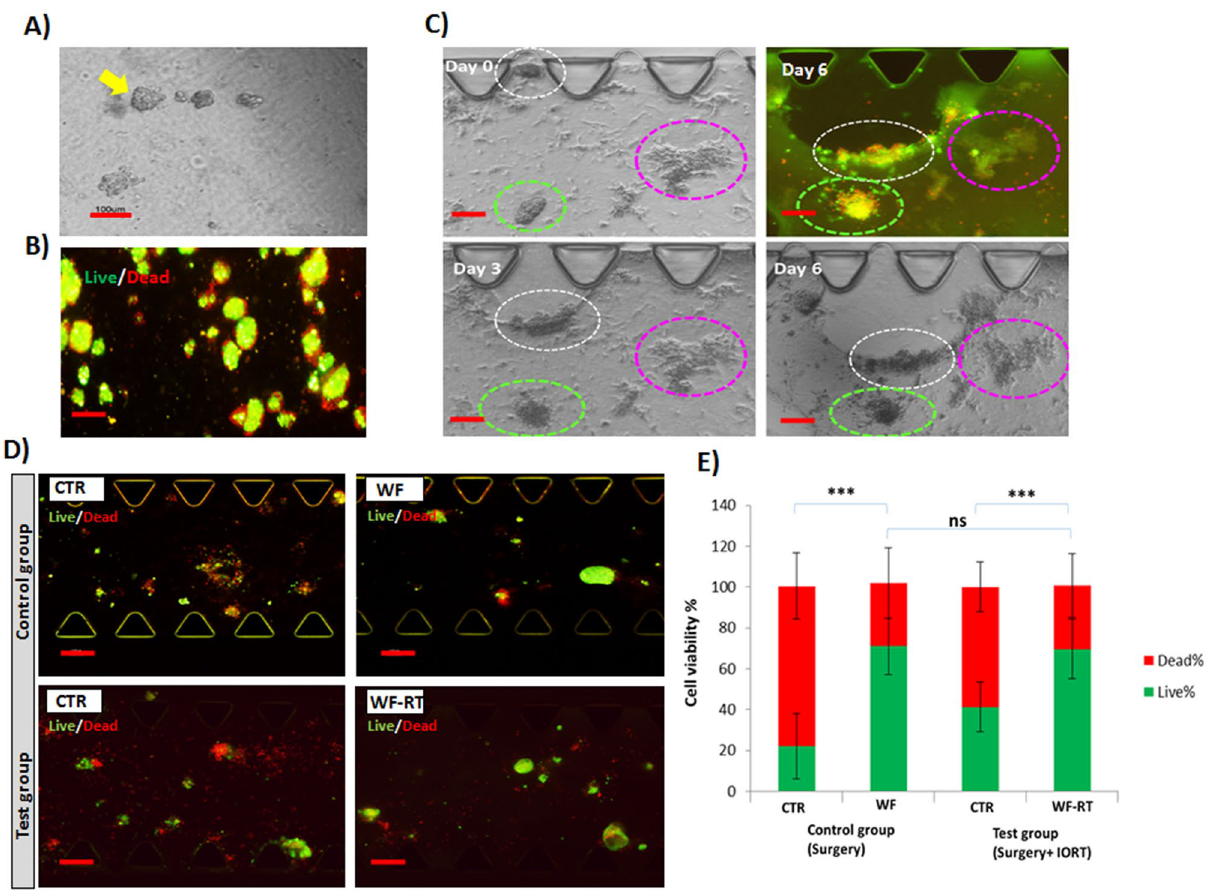
Figure 3. Optical and fluorescent images of spheroids in microfluidic devices on days 0, 1, 3, and 6 of culture. ( A ) Tumor spheroids are observed with a convert microscope before mixing with collagen at day 0. Scale bar: 100 µm. Original magnification: ×40. ( B ) Tumor spheroids stained with AO/PI before injection into the microfluidic devices to find spheroid viability on day 0. Scale bar: 100 µm. Original magnification: ×40. ( C ) The tumor-derived spheroids were treated with WF-RT on days 0, 3, and 6 with inverted phase-contrast microscopy and fluorescent microscopy. Different behaviors of three types of spheroids treated with WF-RT were traced for 6 days and shown with the circular dotted line. White dotted lines show motility of the spheroids during 6 days, while green ones represent the in-situ proliferation of cells within the spheroids and pink ones represent the spheroid without proliferation and motility. Scale bars: 100 µm. Original magnification: ×40. ( D ) live/ dead staining of the spheroids under RPMI treatment comparing wound fluid treatment in a control sample (spheroids from the non-IORT treated patient) and a test sample (spheroids from IORT treated patient). Scale bars: 100 µm. Original magnification: ×40. Green: AO/live cells; Red: PI/dead cells. ( E ) The graph presents the comparison of %live and %dead cells in control samples with test samples and between RPMI and WF treated cells in each group. Control group: patients who only went under surgery, test group: patients who received IORT during the surgery. CTR control (RPMI + 10%FBS), WF wound fluid, WF-RT IORT-treated wound fluid. ns: non-significant. ***P <